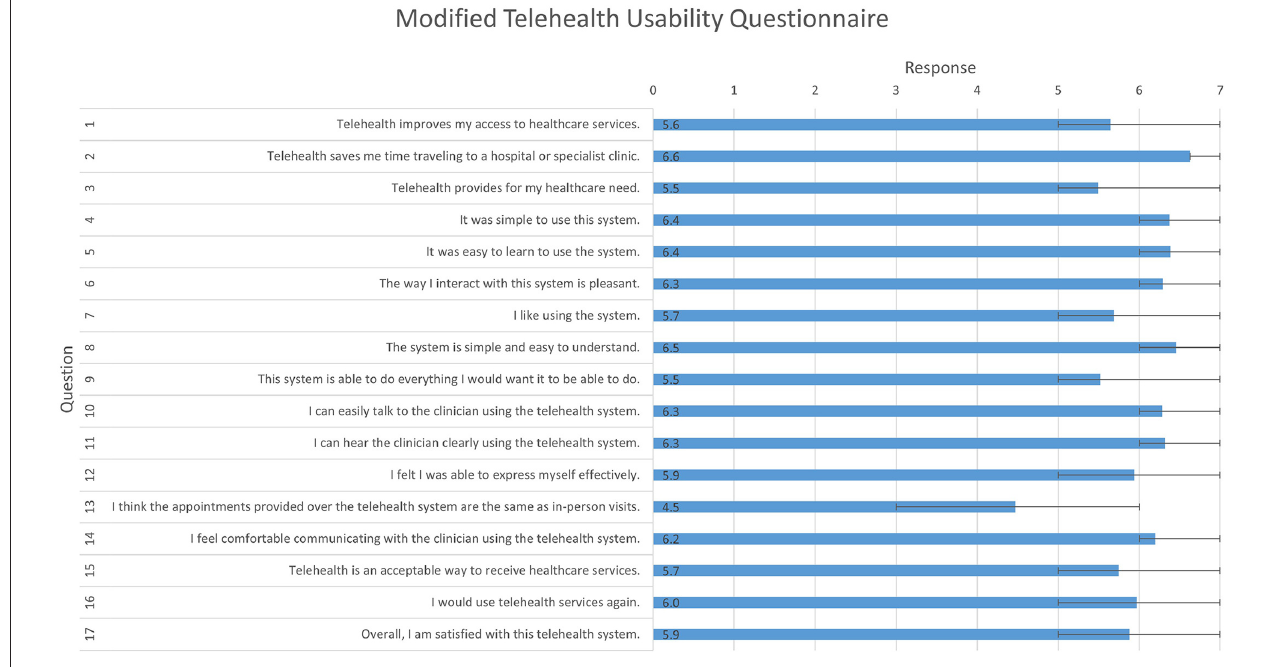
FIGURE 2 | Modified Telehealth Usability Questionnaire, responses to quantitative questions. Likert scale; 1 (disagree) to 7 (agree); mean and interquartile